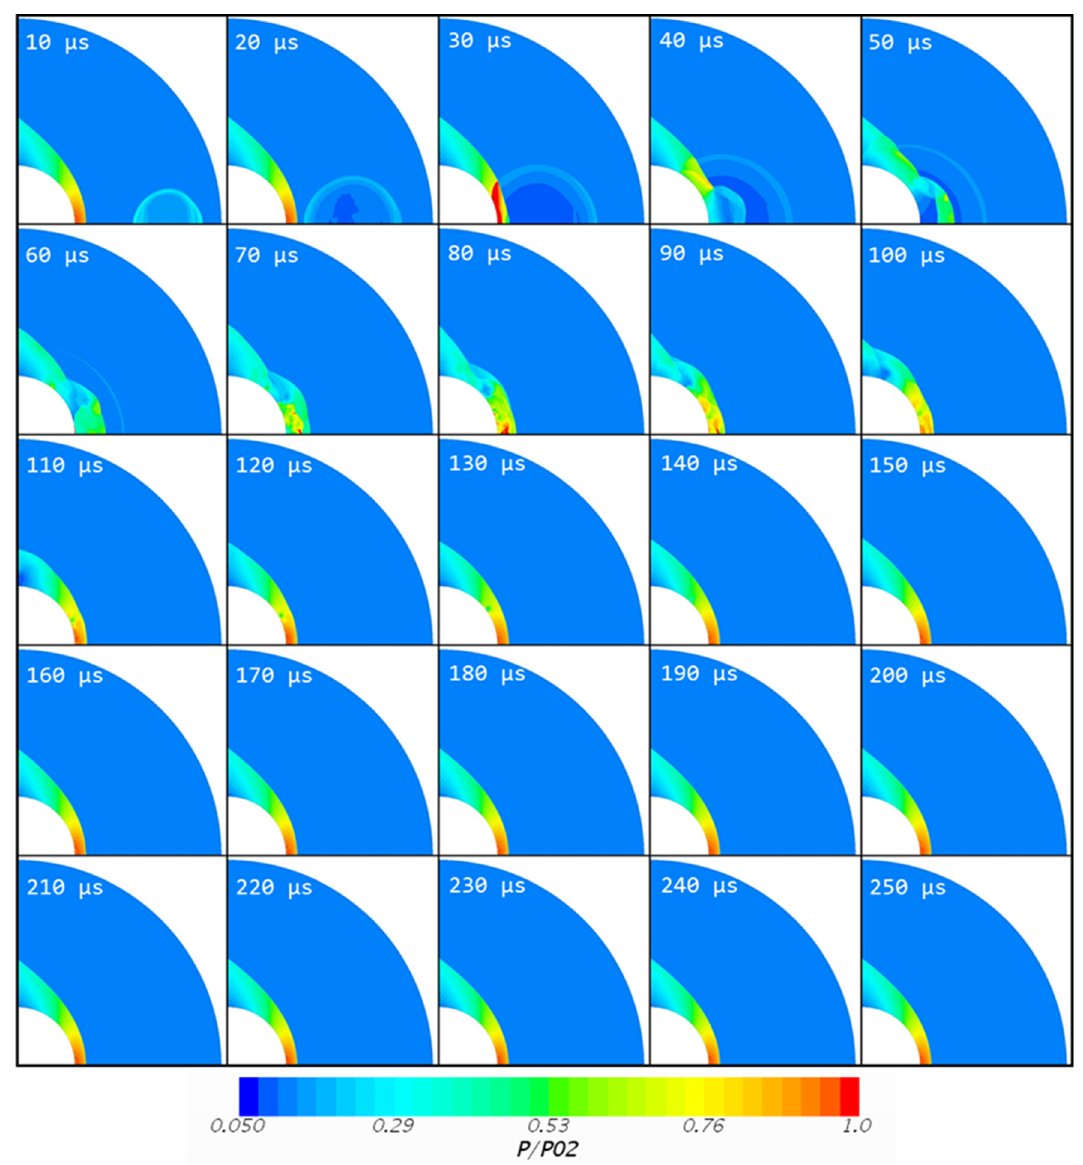
Figure 5. Normalized pressure contours vs. time for deposition frequency of 1 Hz.